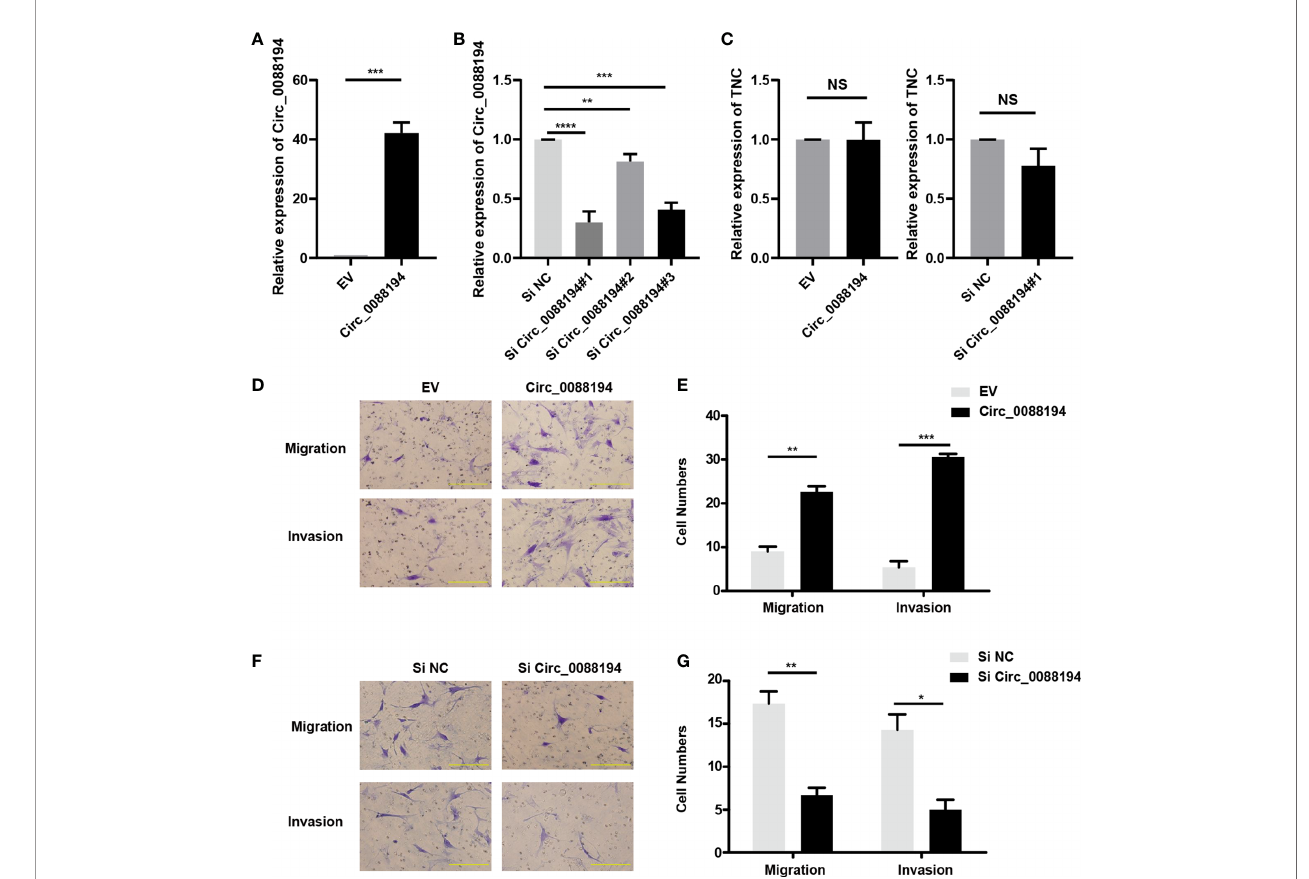
FIGURE 2 | Circ_0088194 promotes RA-FLS migration and invasion. (A) RA-FLSs were infected with adenovirus expressing Circ_0088194 or with the empty vector (EV). The expression levels of Circ_0088194 were detected using qRT-PCR. (B) RA-FLSs were transfected with three Circ_0088194 siRNAs or the negative control (NC). The Circ_0088194 expression level was measured using qRT-PCR (C) RA-FLSs were infected with adenovirus expressing Circ_0088194 or Circ_0088194#1 siRNA, respectively. The Tenascin C ( TNC ) expression level was measured using qRT-PCR. (D, E) Transwell migration and Matrigel invasion assays were used to evaluate the migratory and invasive activity of RA-FLSs. RA-FLSs were infected with adenovirus expressing Circ_0088194 or the EV. Scale bar, 500 µm. (F, G) RA- FLSs transfected with Circ_0088194#1 siRNA, or NC. Transwell migration and Matrigel invasion assays were used to evaluate the migratory and invasive activity of RA-FLSs. Scale bar, 500 µm. Data are shown as mean ± SD. NS, not signi fi cant. *indicates p < 0.05, **indicates p < 0.01, ***indicates p < 0.001, and ****indicates p < 0.0001.